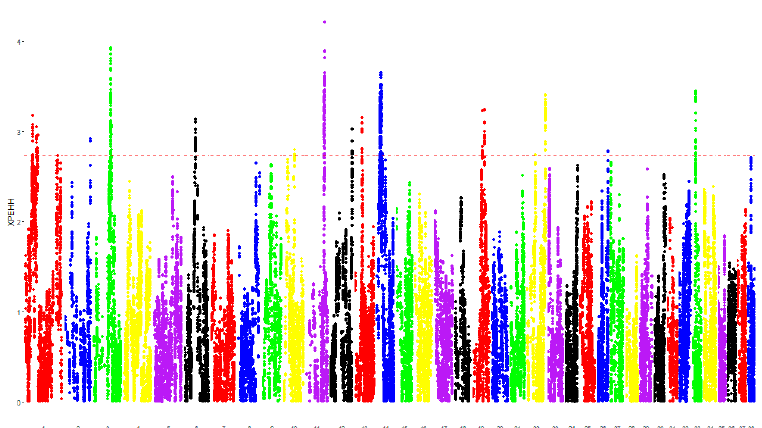
Figure 1. Manhattan plots of the Wright’s fixation index (F ST ) analysis comparing cases vs. controls. Each single-nucleotide polymorphism (SNP) is represented by a dot. Each chromosome is represented by a different color. The dotted red line represents the cutoff value of the top 1%, equal to 0.19. The genomic regions in which SNPs were mapped over the dotted red line were considered as significantly different between the two compared groups.